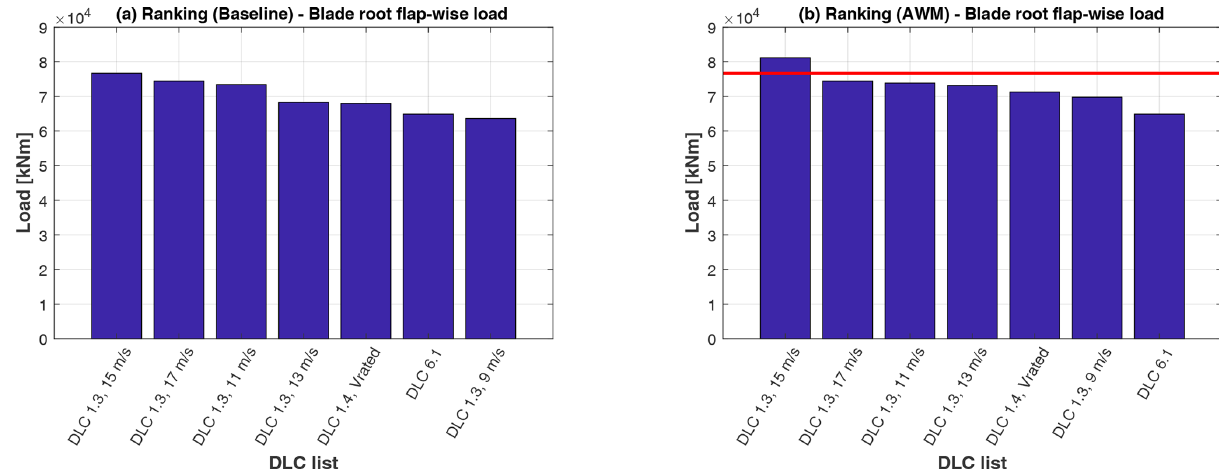
Figure 4. Ranking of ultimate loads for blade root flap-wise load for baseline (b) and PCM (a) in the case of St = 0 . 5 and β PCM = 2 ◦ . The red line shows the baseline ultimate load.